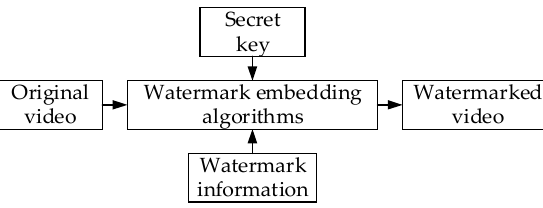
Figure 5. The model of embedding process.